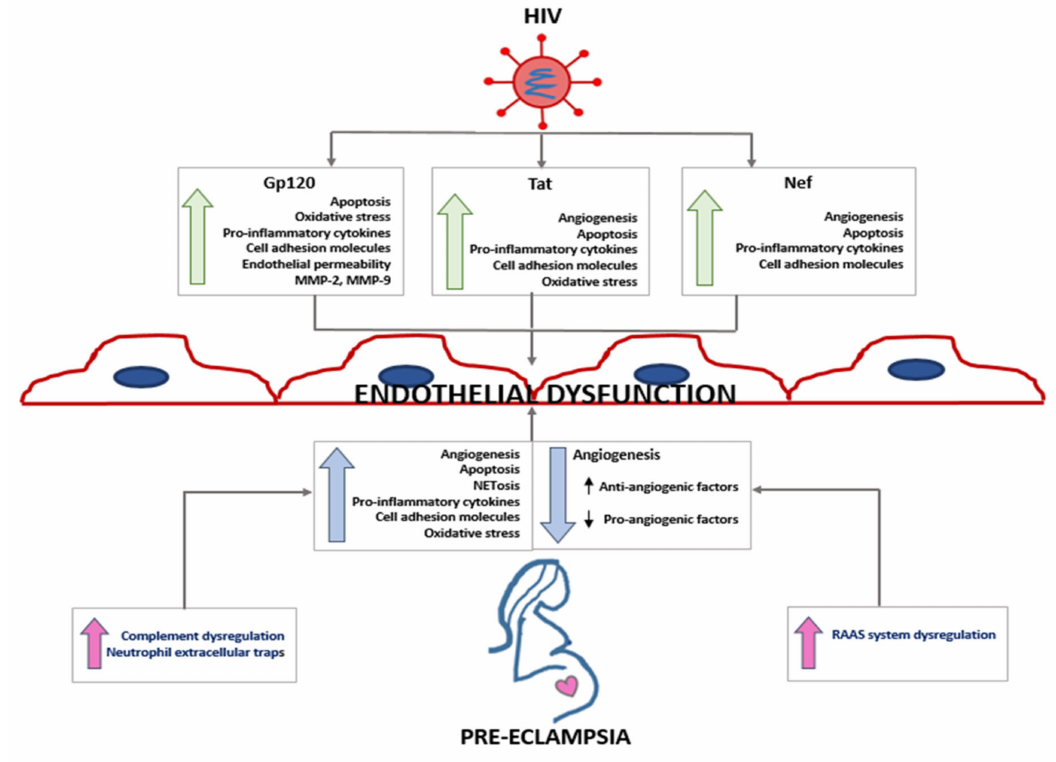
Figure 1. The homology between HIV-1 and PE response to endothelial dysfunction. HIV-1 accessory proteins gp120, tat and nef, as well as matrix proteins, are protagonists of the cellular machinery that culminate in endothelial cell dysfunction. Adapted from